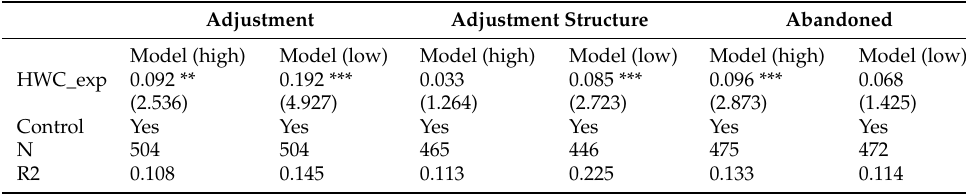
Table 5. Income differences.